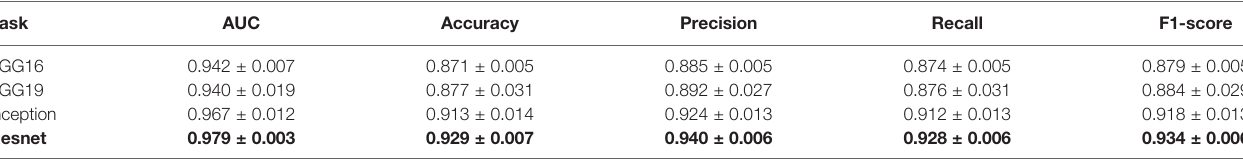
TABLE 1 | Results of comparison between different feature extraction networks in 5-fold cross-validation experiments.